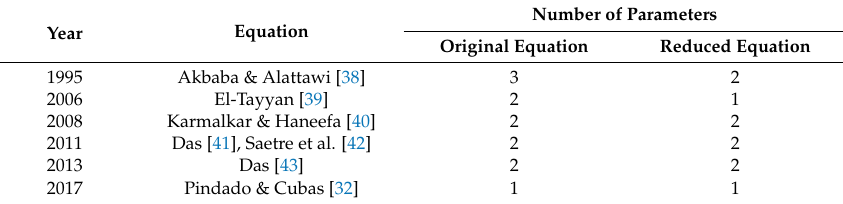
Table 1. Explicit equations for solar cell/panel behavior included in this study. The number of parameters in each equation proposed is included in the table. The number of parameters in the reduced equation refers to the number of parameters in the equation once it has been reduced to non-dimensional variables (i.e., non-dimensional output current and output voltage; see Section 2).